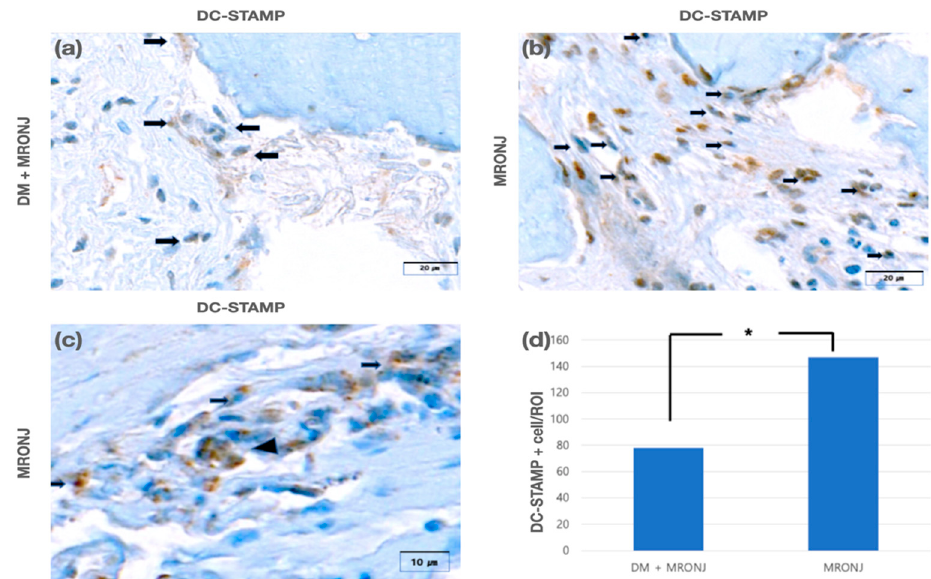
Figure 5. ( a ) DC-STAMP-positive cells (arrow) in the DM + MRONJ group (anti-DC-STAMP staining). ( b ) DC-STAMP-positive cells (arrow) in the MRONJ group (anti-DC-STAMP staining). ( c ) DC-STAMP-positive osteoclasts (arrowhead) in the MRONJ group (anti-DC-STAMP staining). ( d ) There were significantly fewer DC-STAMP-positive mononuclear cells in the DM + MRONJ group than in the MRONJ group (* p < 0.05).